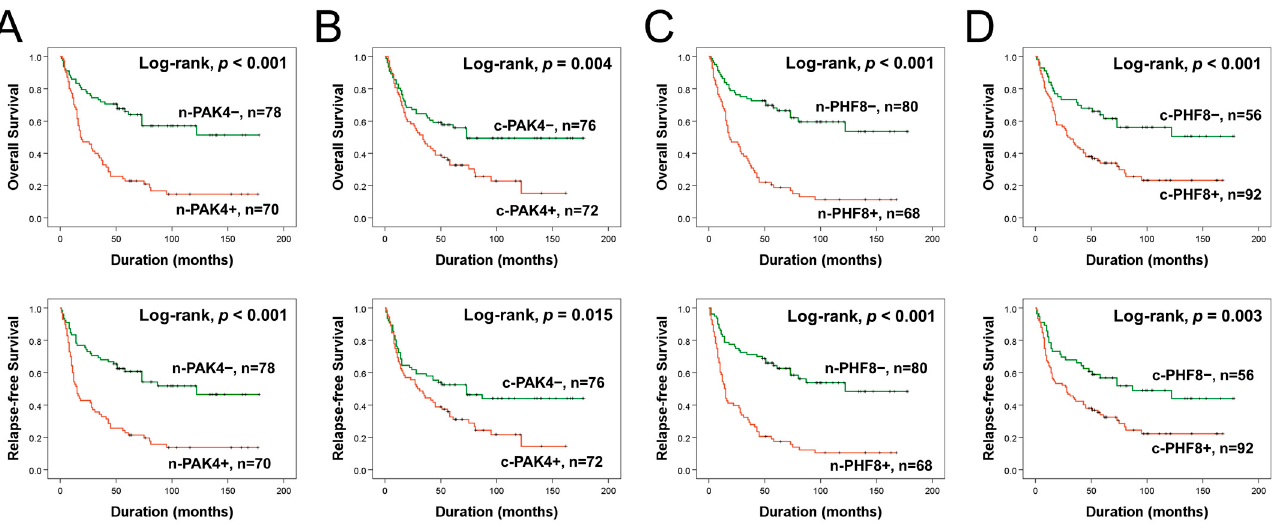
Figure 2. Kaplan–Meier survival curves of OS and RFS according to the expression of nuclear PAK4